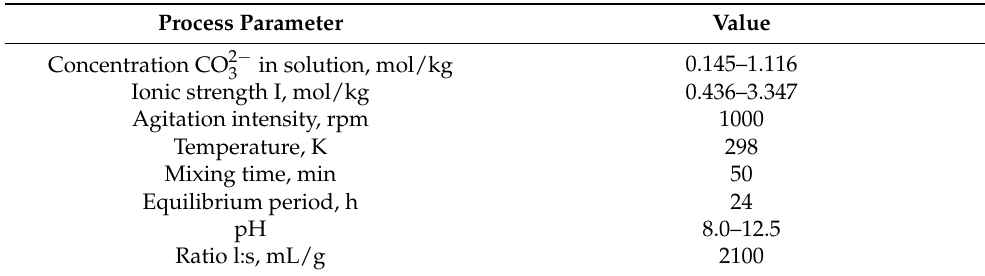
Table 1. Parameters of sediment carbonation of